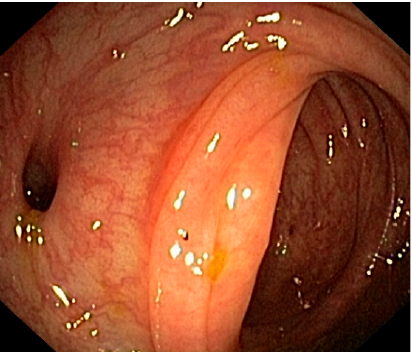
Figure 4. Endoscopic appearance of the colon eight weeks after an episode of uncomplicated diverticulitis. No signs of inflammation may be detected, and the patient risks being mis-scored according to the DICA classification.